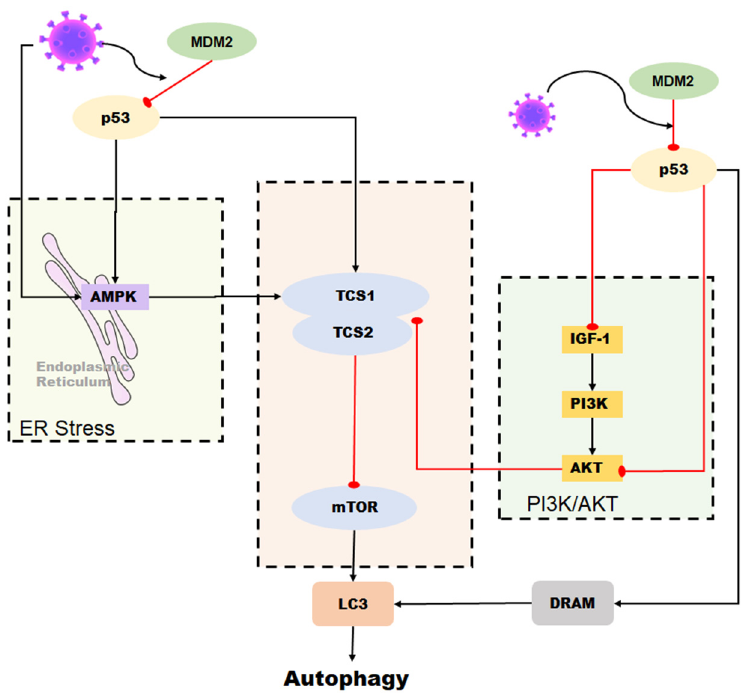
Figure 5. Role of p53 in the regulation of autophagy during coronavirus infection. Autophagy can be induced by p53 through the DRAM protein. In some coronaviruses, autophagy is activated by p53-mediated DRAM protein as well as through the AMPK pathway and the PI3K/AKT pathway. However, some coronaviruses can reduce the stability of p53 in cells and inhibit p53-mediated autophagy by upregulating the expression of MDM2.